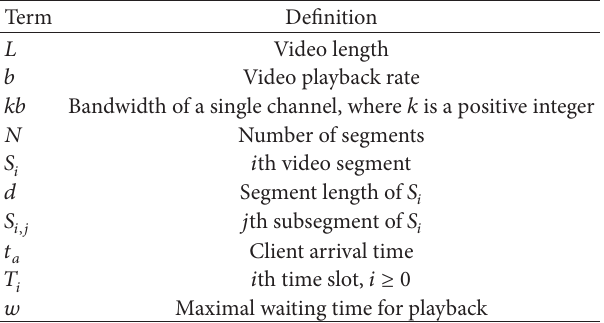
Table 1: List of terms used in this study and their respective